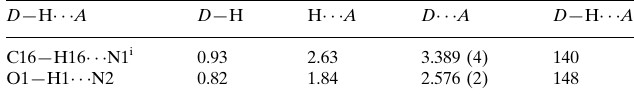
Hydrogen-bond geometry (A˚ , (cid:1)